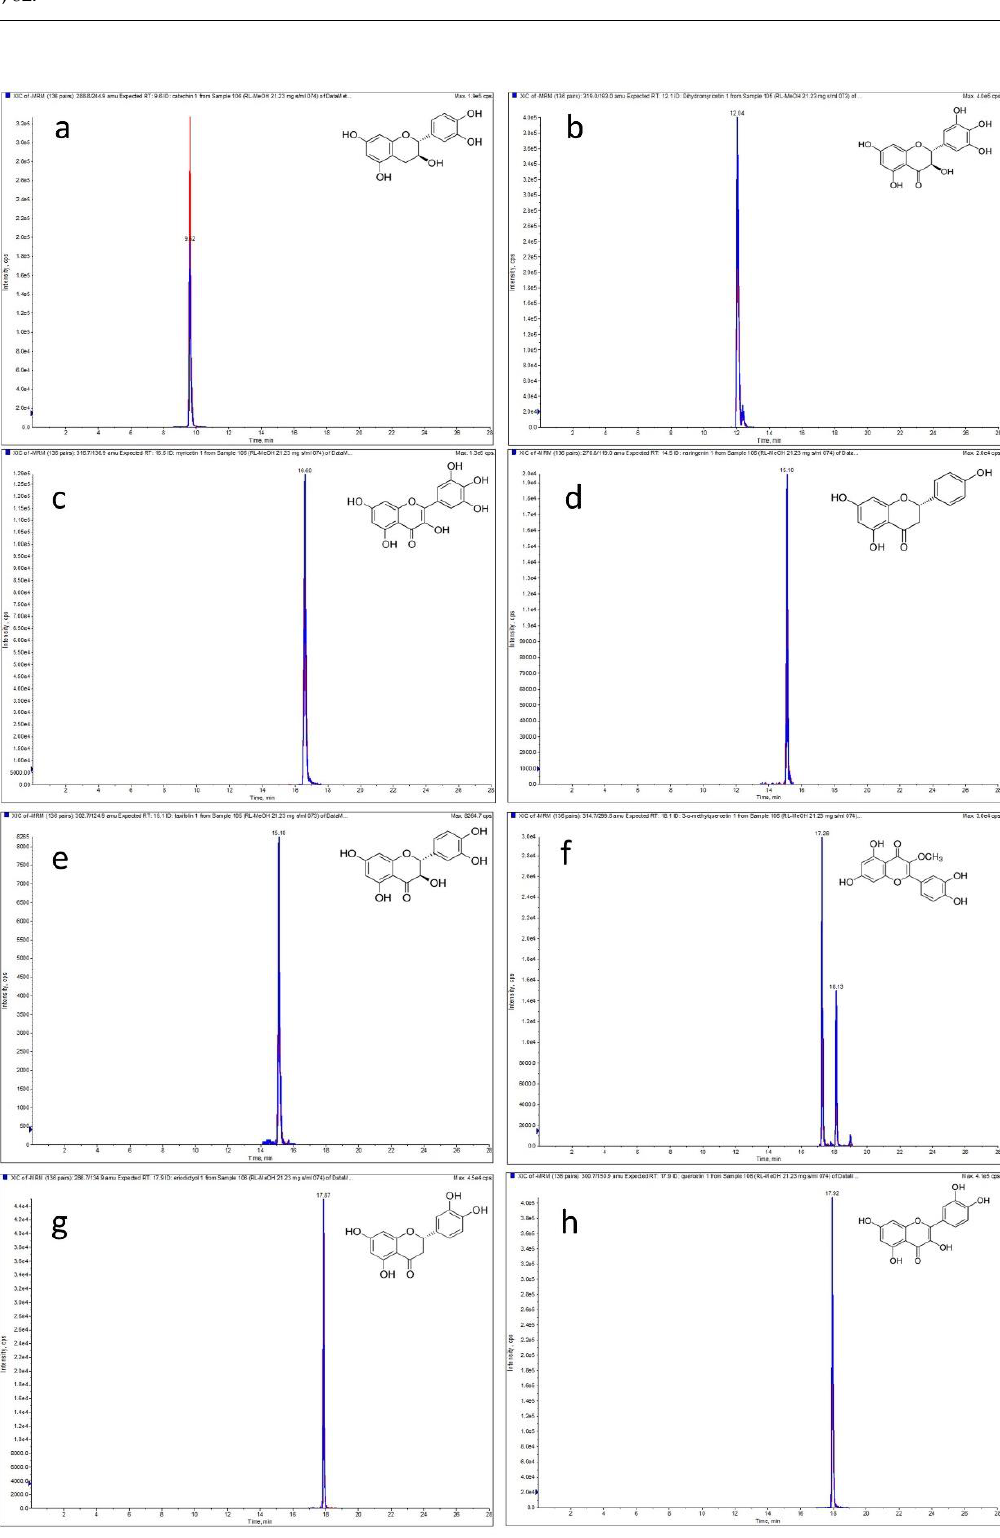
Figure 1. LC-MS chromatograms obtained in the multiple reaction monitoring (MRM) mode of flavonoid aglycones detected in R. luteum leaves (sample RL-M). Monitored MRM transitions are given in the brackets: a : catechin (m/z 288.8 → 109; 288.8 → 244.9); b : dihydromyricetin (m/z 319 → 193; 319 → 125); c : myricetin (m/z 316.7 → 136.9; 316.7 → 150.9); d : naringenin (m/z 270.8 → 119; 270.8 → 150.9); e : taxifolin (m/z 302.7 → 124.9; 302.7 → 284.8); f : 3- O -methylquercetin (m/z 314.7 → 299.8; 314.7 → 270.8); g : eriodictyol (m/z 286.7 → 134.9, 286.7 → 150.9); h : quercetin (m/z 300.7 → 150.9; 300.7 → 178.8).